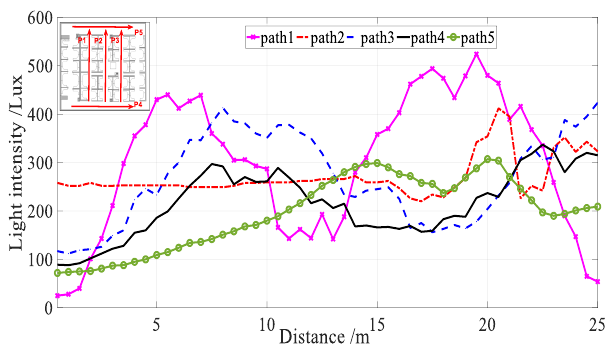
Figure 3. The location differentiation ability of light signals.